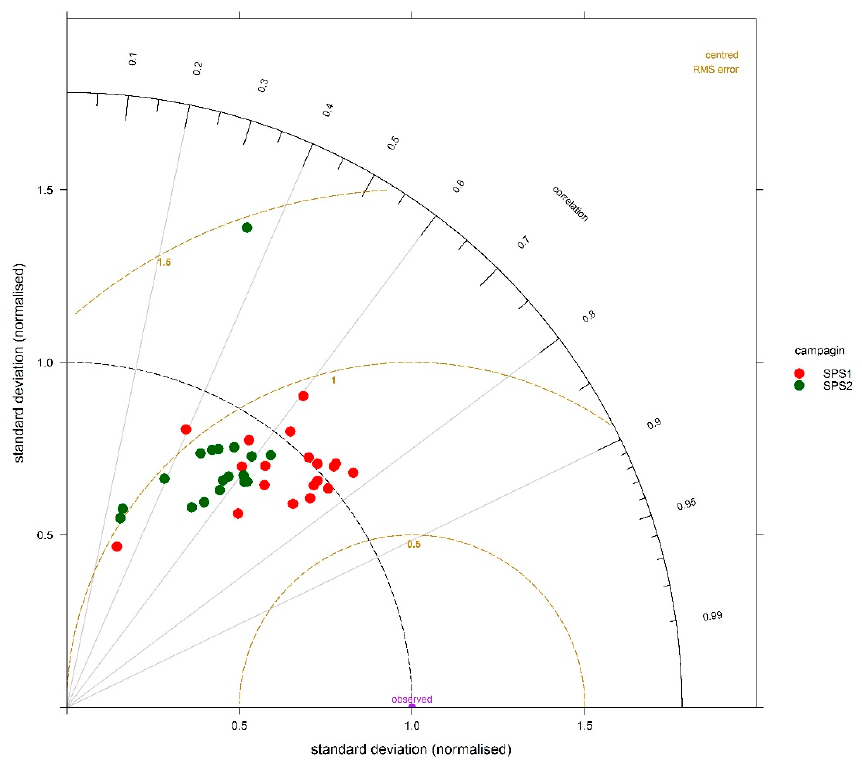
Figure 9. Tayler diagram of hourly O 3 for all predicted/observed pairs of values at 18 OEH stations for SPS1 (red dot) and SPS2 (green dot).